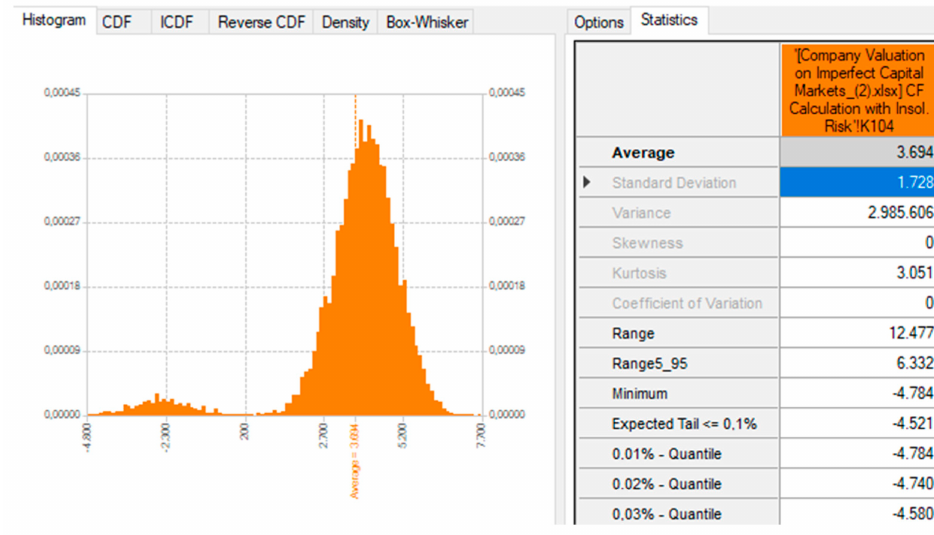
Figure 6. Frequency distribution and statics of the cashflow to equity in the TV.